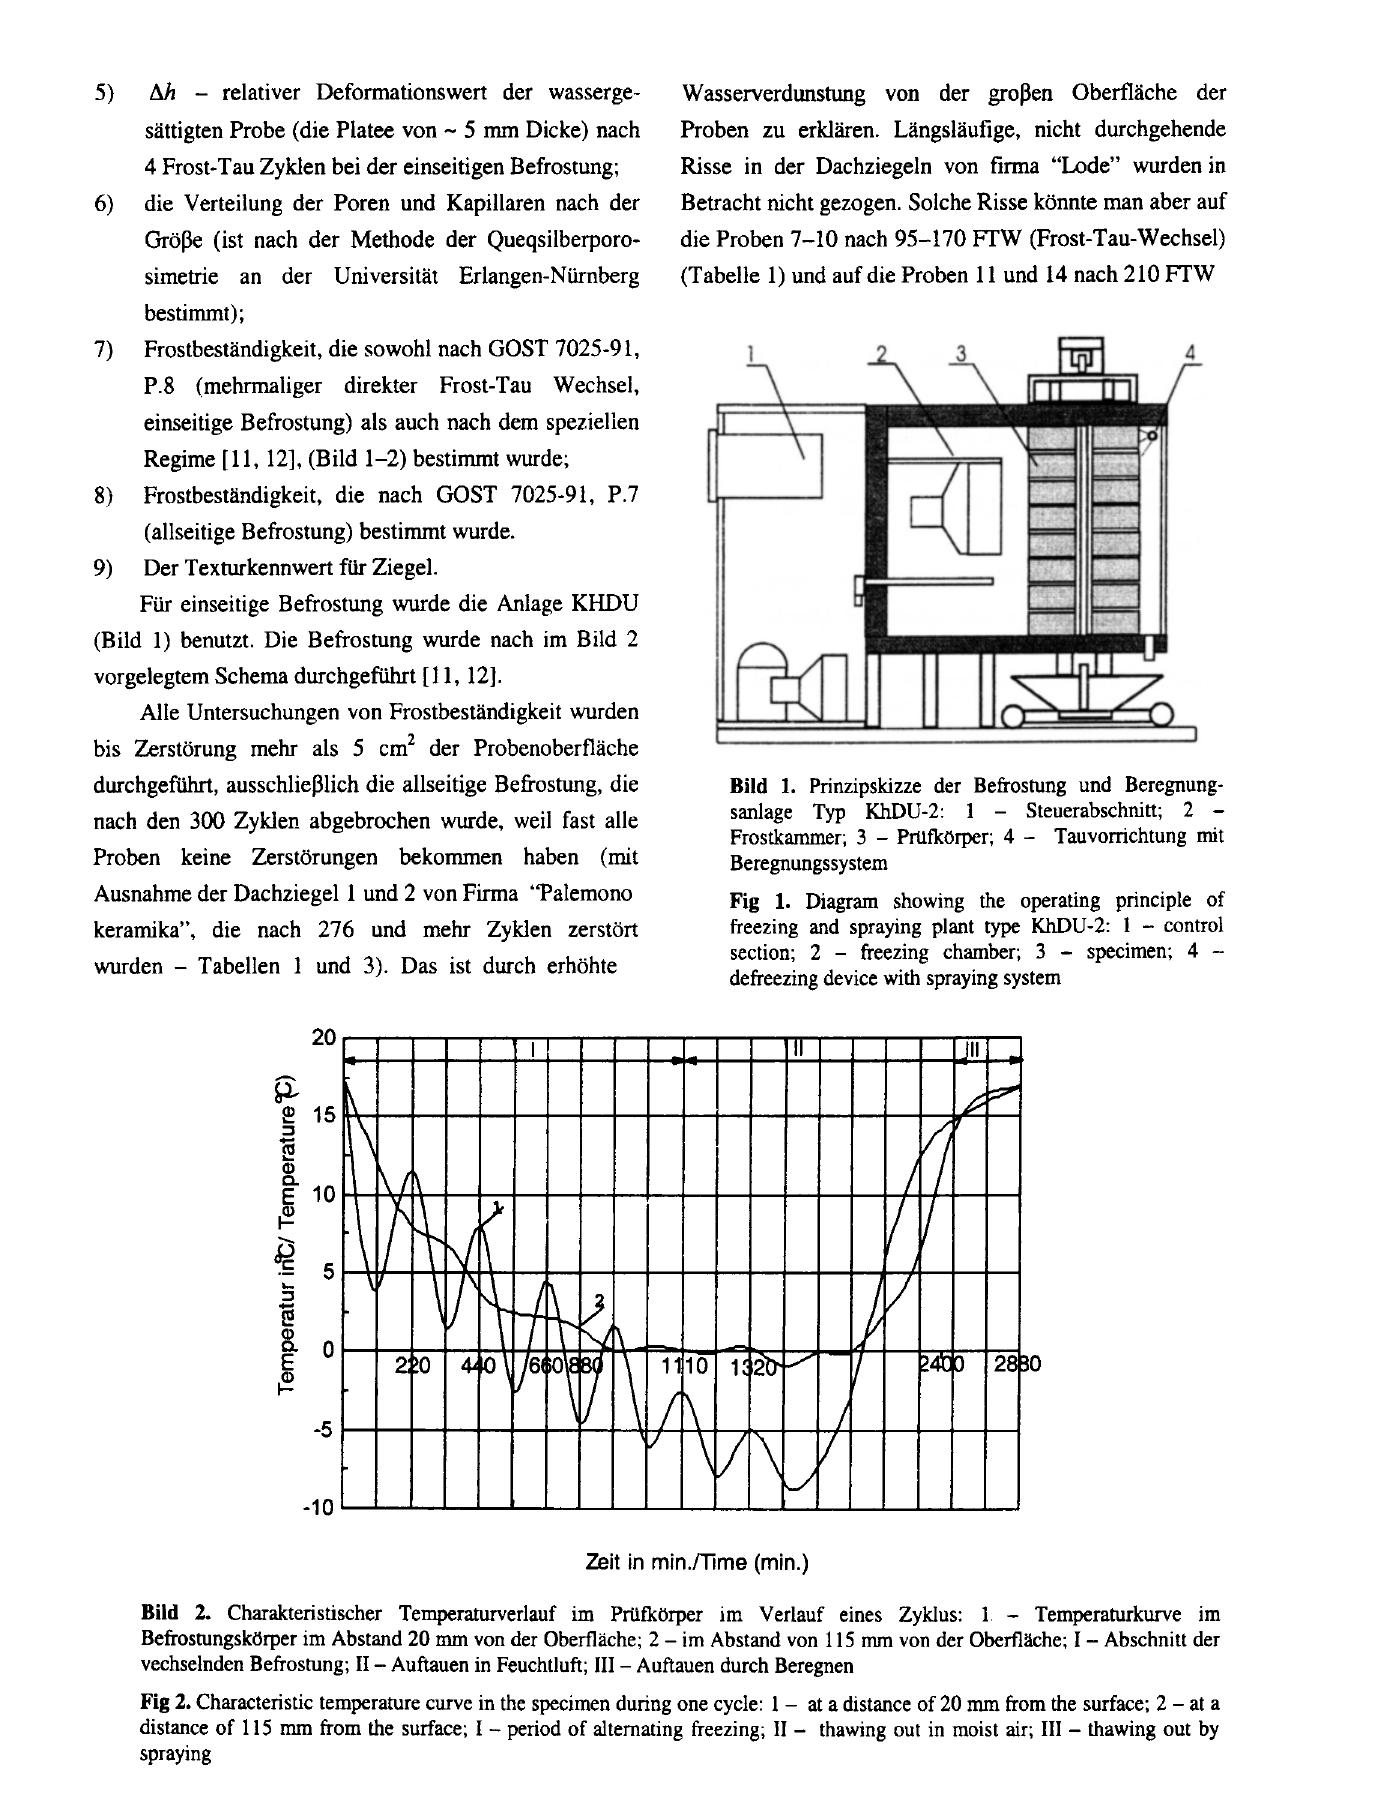
Bild 2. Charakteristischer Ternperaturverlauf im Priitk6rper im Verlauf eines Zyklus: I. - Temperaturkurve im Befrostungskllrper im Abstand 20 rnrn von der Oberfliiche; 2- im Abstand von 115 mm von der Oberfliiche; I- Abschnitt der vechselnden Befrostung; II- Auftauen in Feuchtluft; III - Auftauen durch Beregnen Fig 2. Characteristic temperature curve in the specimen during one cycle: 1 - at a distance of 20 rnrn from the surface; 2 - at a distance of 115 rnrn from the surface; I- period of alternating freezing; II- thawing out in moist air; III- thawing out by